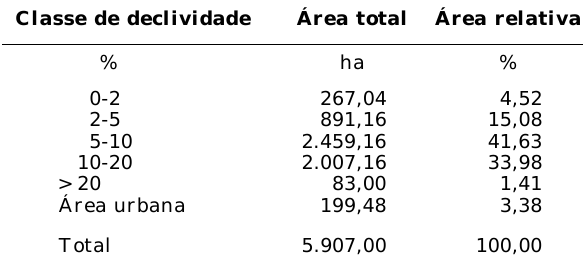
= 3; (d) risco alto (A), F = 4; (c) risco médio (M), F i i (e) risco muito alto (MA), F = 5. i Os mapas básicos utilizados no cruzamento de dados no SIG foram o mapa pedológico na escala 1:20.000, obtido por meio de levantamento de campo (Teramoto, 1995), os mapas planialtimétricos na escala 1:10.000, do Instituto Geográfico e Cartográfico, e o mapa de uso da terra, obtido por meio de observações de campo e interpretação de fotografias aéreas de julho de 1995 na escala 1:25:000. A